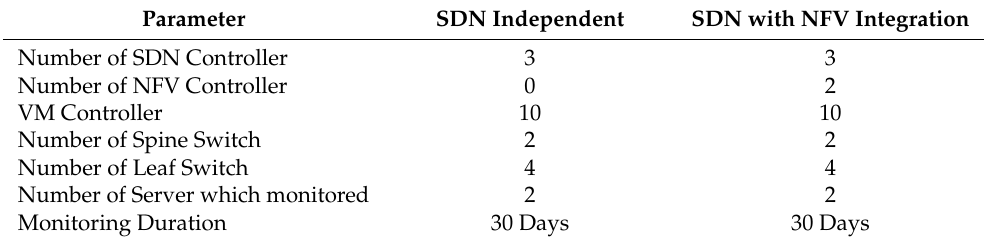
Table 4. Simulation parameter.